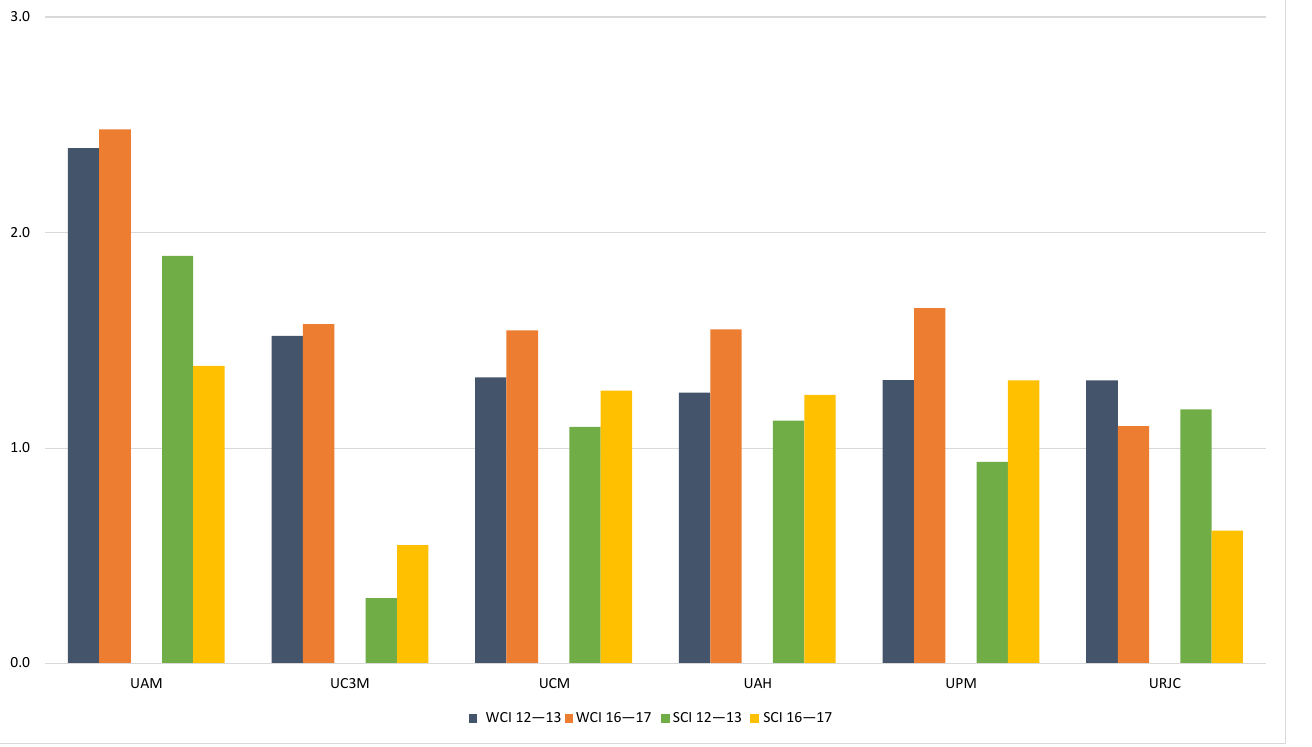
Figure 8. Evolution in the research mission of the Madrid public university system from 2012–2013 to